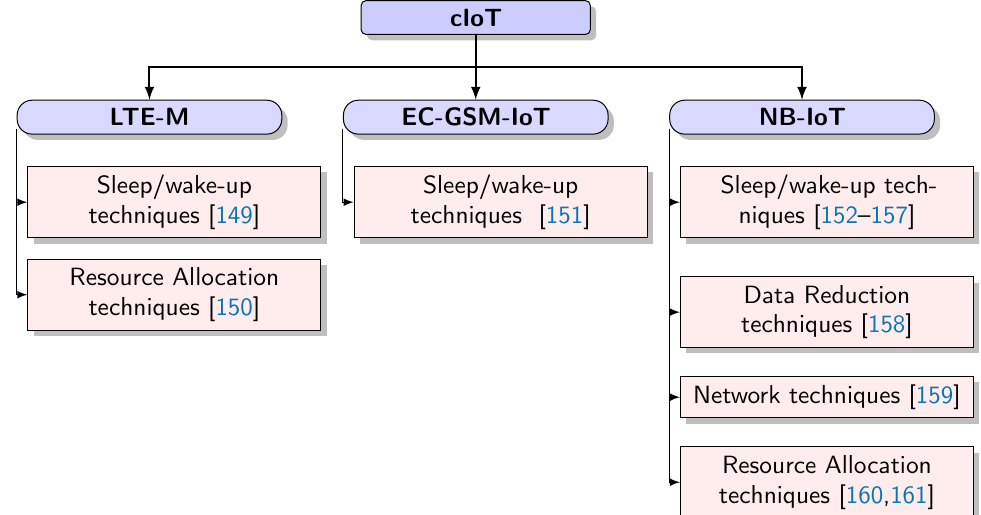
Figure 8. Energy efficiency techniques for cIoT technologies [149–161]. Sleep/wake-up techniques. NB-IoT uses two advanced mechanisms, that is PSM and eDRX. PSM makes it possible for the device to enter in a deep sleep mode within the RRC Idle state, so to minimize its consumption. In this situation, the device is still registered to the network but cannot be reached. Then, if the Mobile Mobility Entity (MME) receives a downlink data notification, it notifies the serving base station to cache those data and delay the paging request. The device goes back to Connected mode only when it has data to transmit in uplink [59]. It activates an active timer (AT) when it transits from Connected to Idle, and goes into PSM mode when AT expires. More details on the time structure enabling PSM and eDRX mechanisms are provided in Figure 9. eDRX was introduced in Rel-13, in order to further extend the sleep time during Idle mode. It is an evolution of the DRX technique, already described for LTE-M, which works on both Idle and Connected modes. In Idle, eDRX extends by up to 3 hours, compared to DRX, the time a device is not actively monitoring paging messages [152]. A set of timers, defined in Table 6 controls eDRX processes. In particular, the Active Timer (T3324) which can control the time lapse for which the device is reachable by the network while in Idle. In Connected, the device alternates between listening for paging occasions and sleep periods. eDRX can be used without PSM or in conjunction with PSM. It is responsible for extending the time interval during which a device is not listening to the network. eDRX-specific cycles are reported in Table